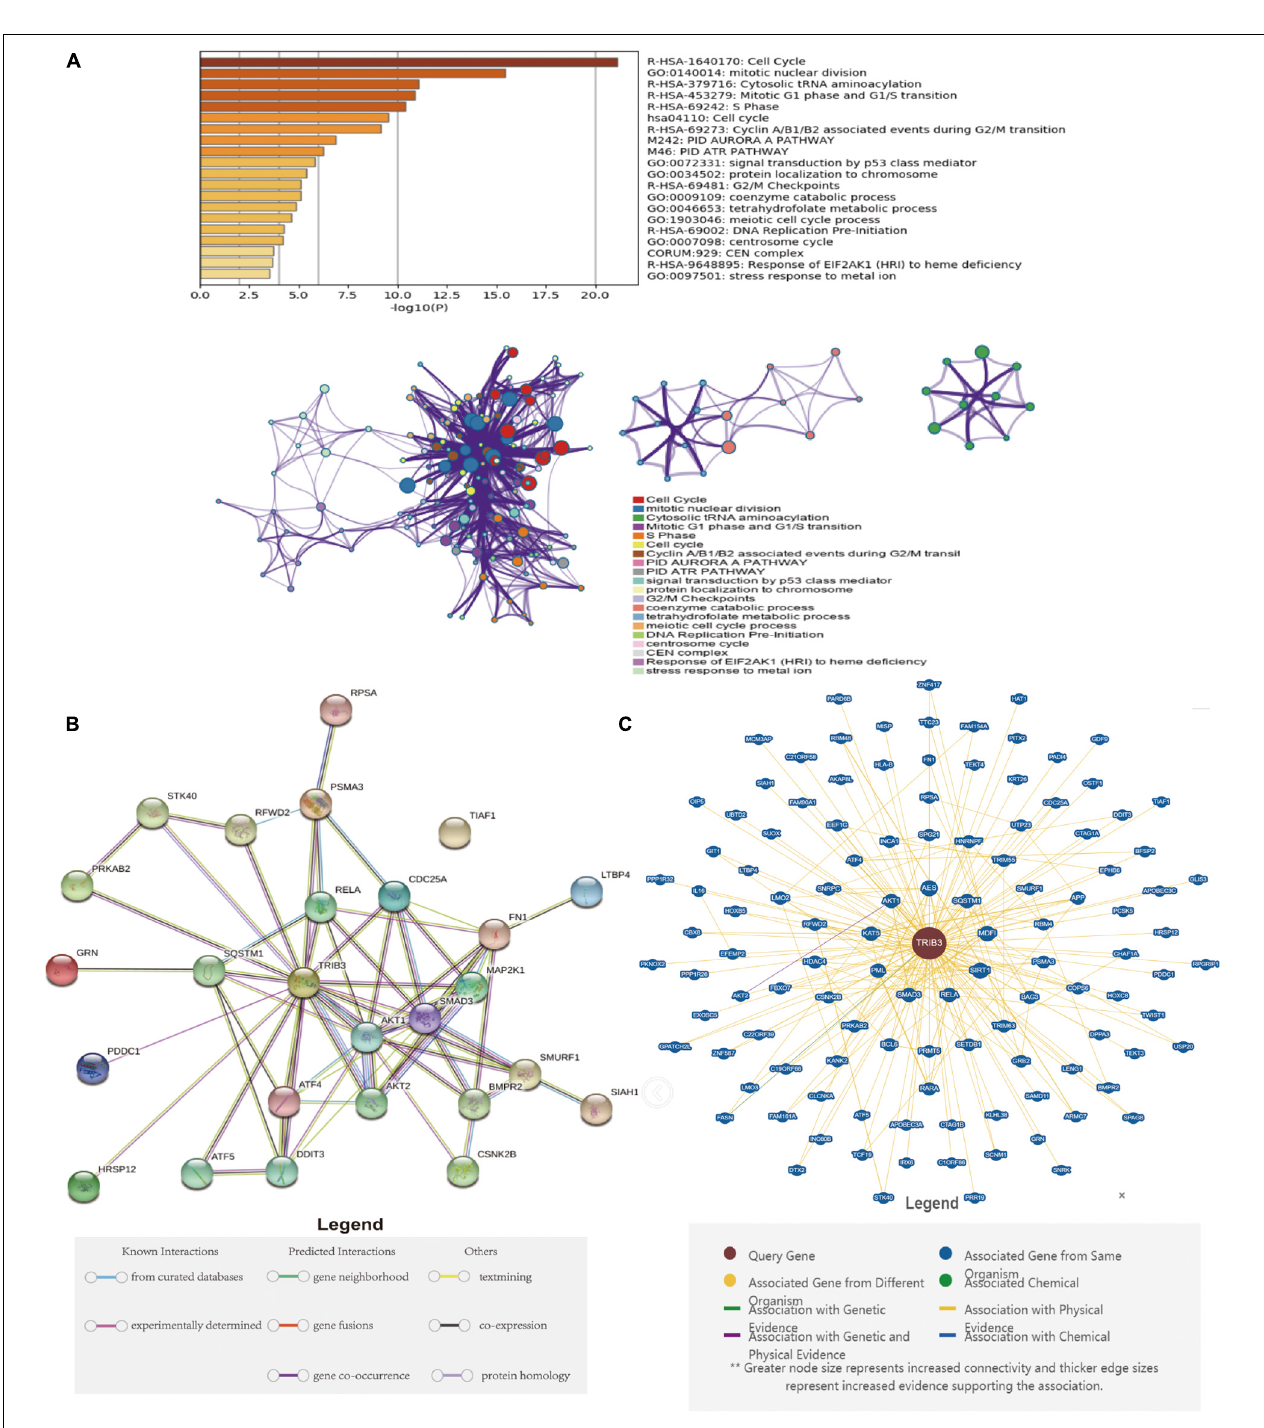
FIGURE 6 | Metascape enrichment analysis and protein interactions. (A) The Metascape enrichment analysis results show that larger log10 (P) correlates with the significance of the enrichment. (B) Protein-protein interactions in the STRING database. (C) Protein-protein interactions in the BioGRID database.